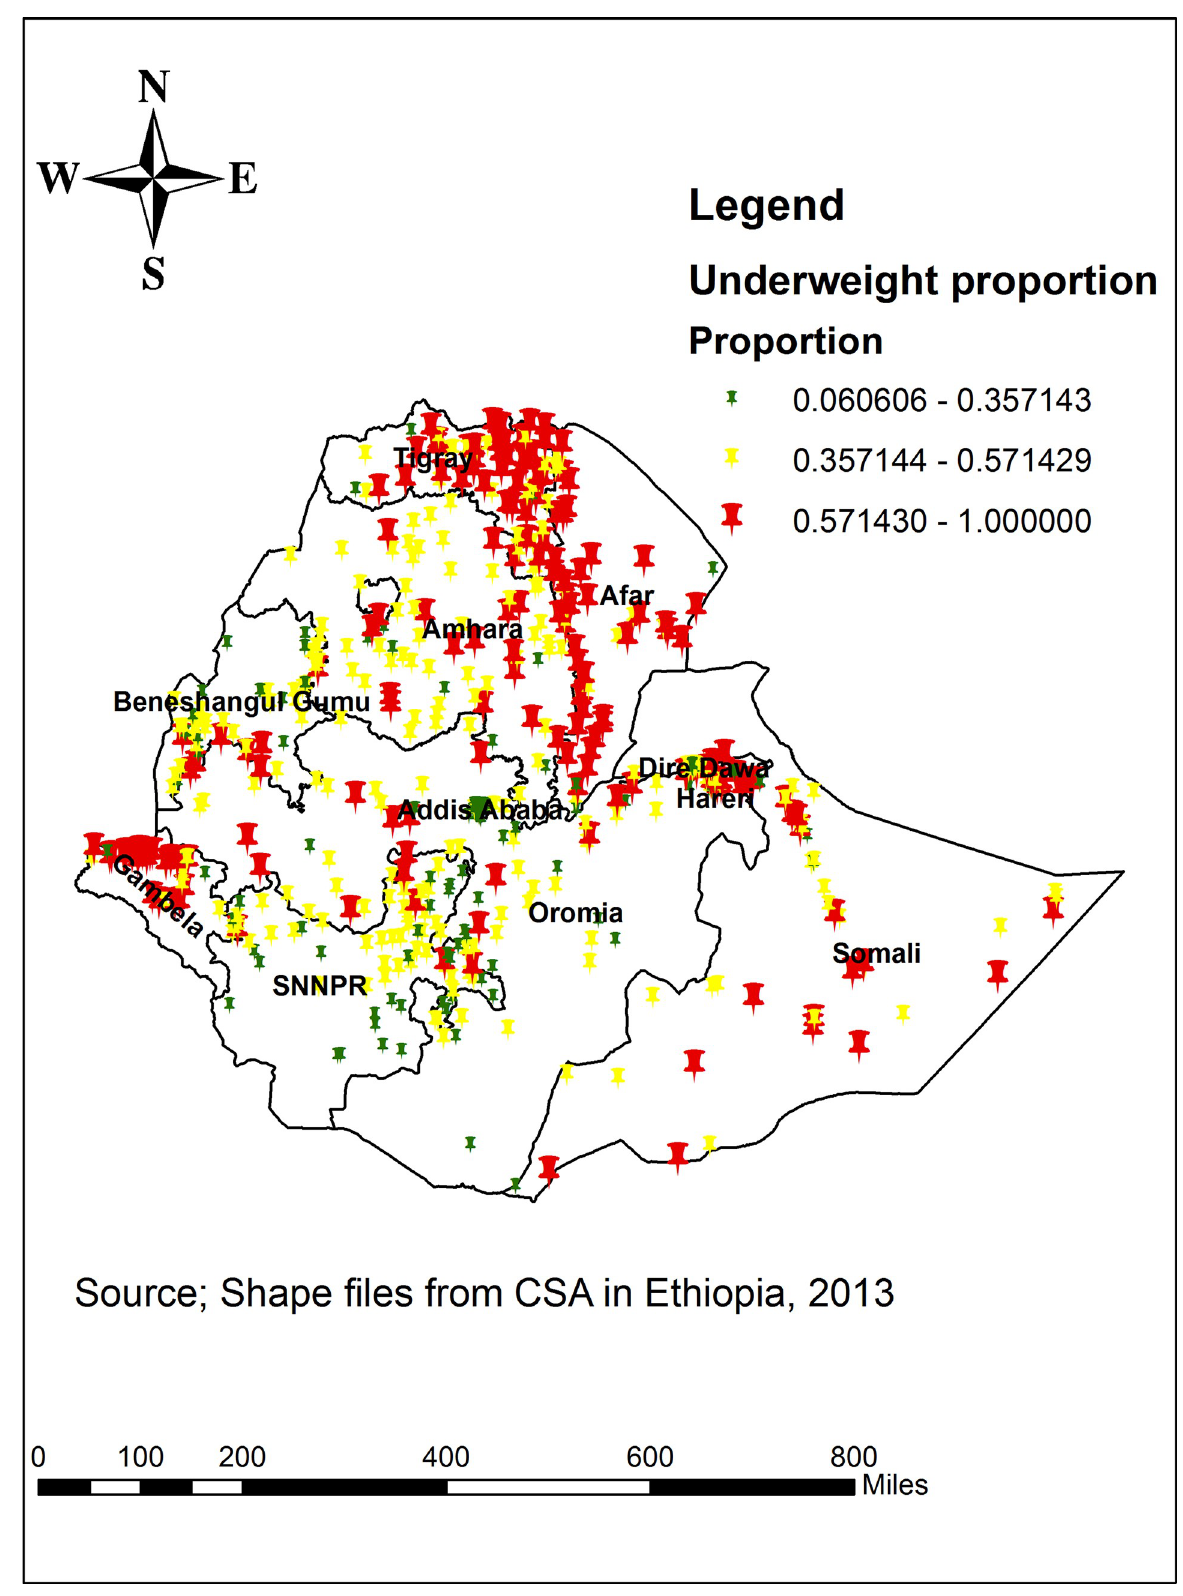
Fig 2. Spatial distribution of underweight across regions among individuals aged 15–49 years in Ethiopia, 2016. https://doi.org/10.1371/journal.pone.0242744.g002 PLOS ONE | https://doi.org/10.1371/journal.pone.0242744 December1, 2020 8 /